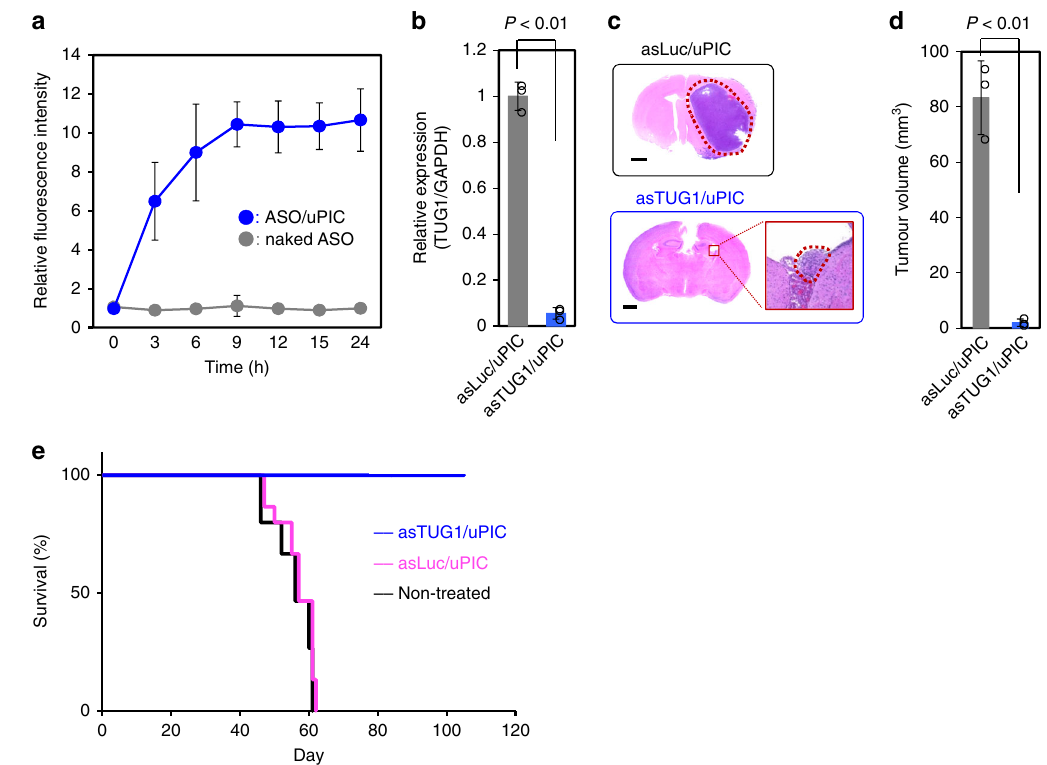
Fig. 5 Delivery performances of ASO/uPIC. a Time-dependent accumulation pro fi les of naked A647-ASO and A647-ASO/uPIC (A/P = 20) in a patient- derived orthotopic brain tumour model, as measured by IVIS. Data represent the means ± s.d. n = 3. b TUG1 expression level in brain tumour tissue. Data represent the means ± s.d. n = 3. c Representative HE-stained whole brain sections at 4 weeks after treatment by intravenous injection of asLuc/ or asTUG1/uPIC. The tumour areas are surrounded by the red dotted line. Scale bars indicate 1 mm. d Tumour volumes at 4 weeks after treatment by intravenous injection of asLuc/ or asTUG1/uPIC. Data represent the means ± s.d. n = 3. e Kaplan – Meier survival curves of orthotopic brain tumour model mice treated with asTUG1/uPIC or asLuc/uPIC. uPIC samples (25 µ g ASO per mouse) were intravenously administrated every three days (total 10 doses). n =